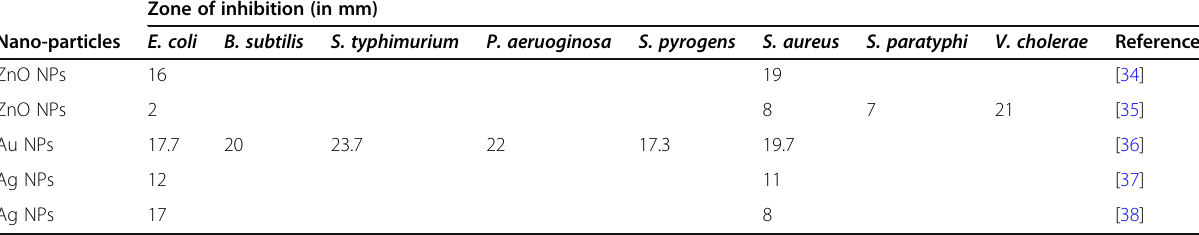
Table 2 Anti-microbial activities (zone of inhibitions in millimeter) of nanoparticles synthesized using VN leaves extract Zone of inhibition (in mm)